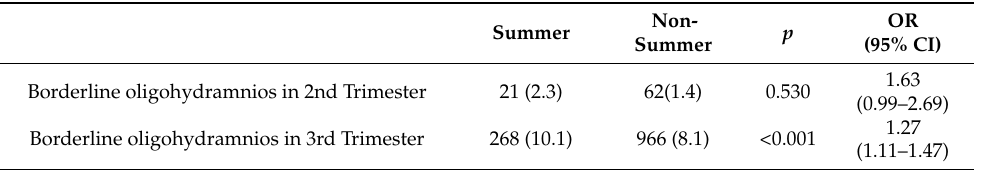
Table 4. Risk of borderline oligohydramnios in summer versus non-summer seasons on 2nd and 3rd trimester of